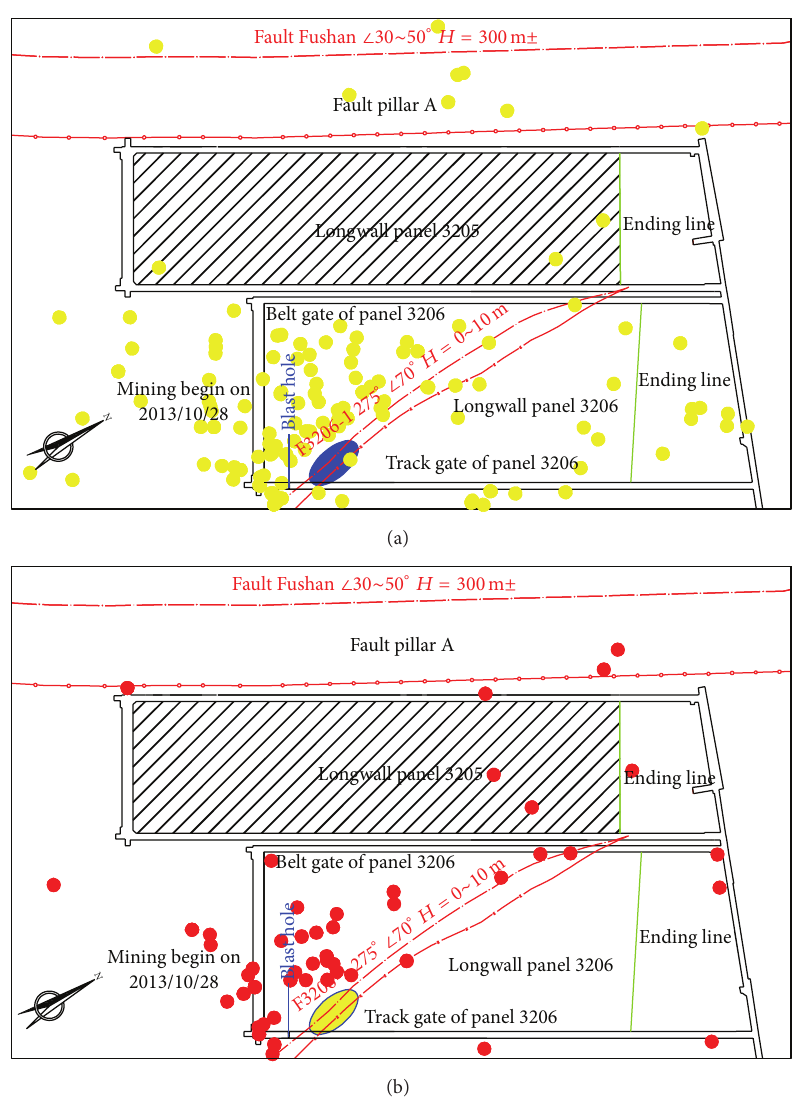
Figure 15: Seismic activity recorded during longwall advance-localization map of recorded seismic events from October 28, 2013, to February 18, 2014. (a) 1000 to 10000 J; (b) >